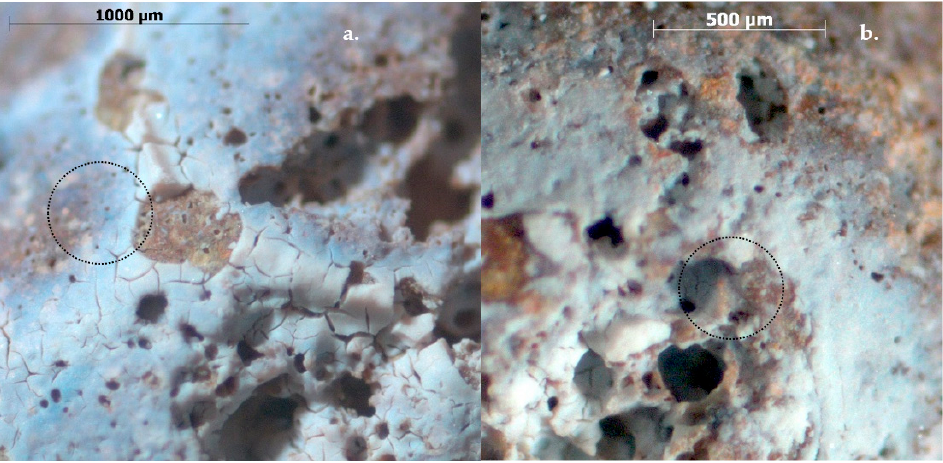
Figure 6. Images obtained through a Zeiss Stemi 200-C magnifier showing the solvent effect on impregnation: ( a ) water; ( b ) ethanol.